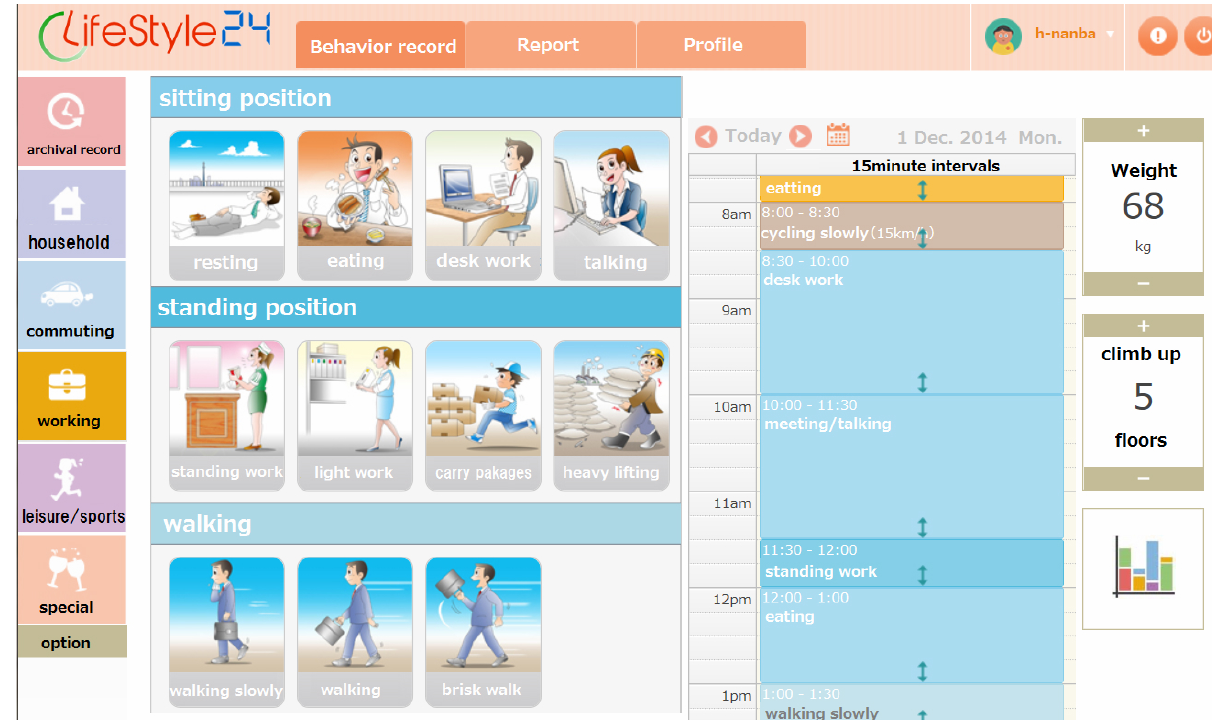
Figure 1. Screenshot of the Web-based physical activity record system.